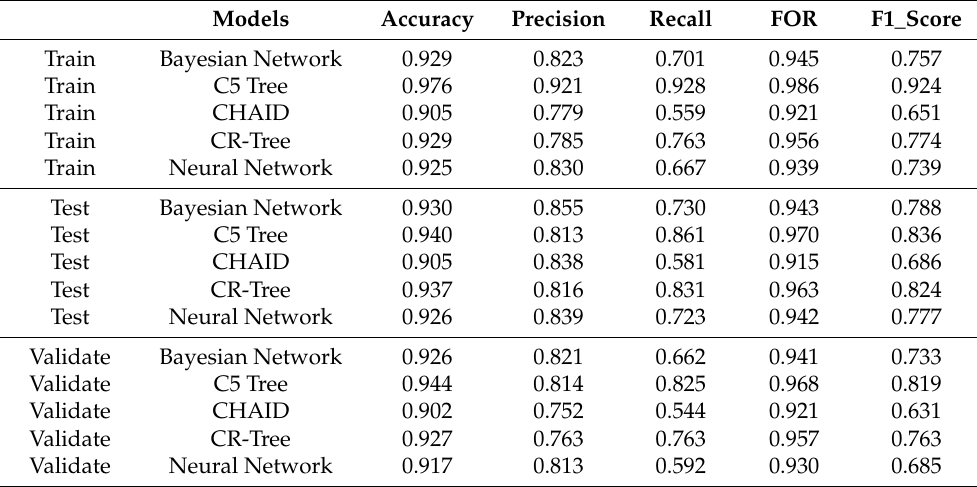
Table 5. The developed customer churn model based on feature selection.